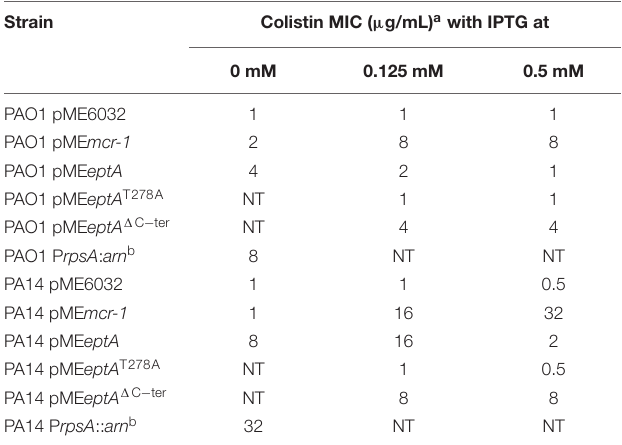
TABLE 1 | MIC of colistin for P. aeruginosa PAO1 and PA14 expressing or not MCR-1, EptA or EptA variants. Strain